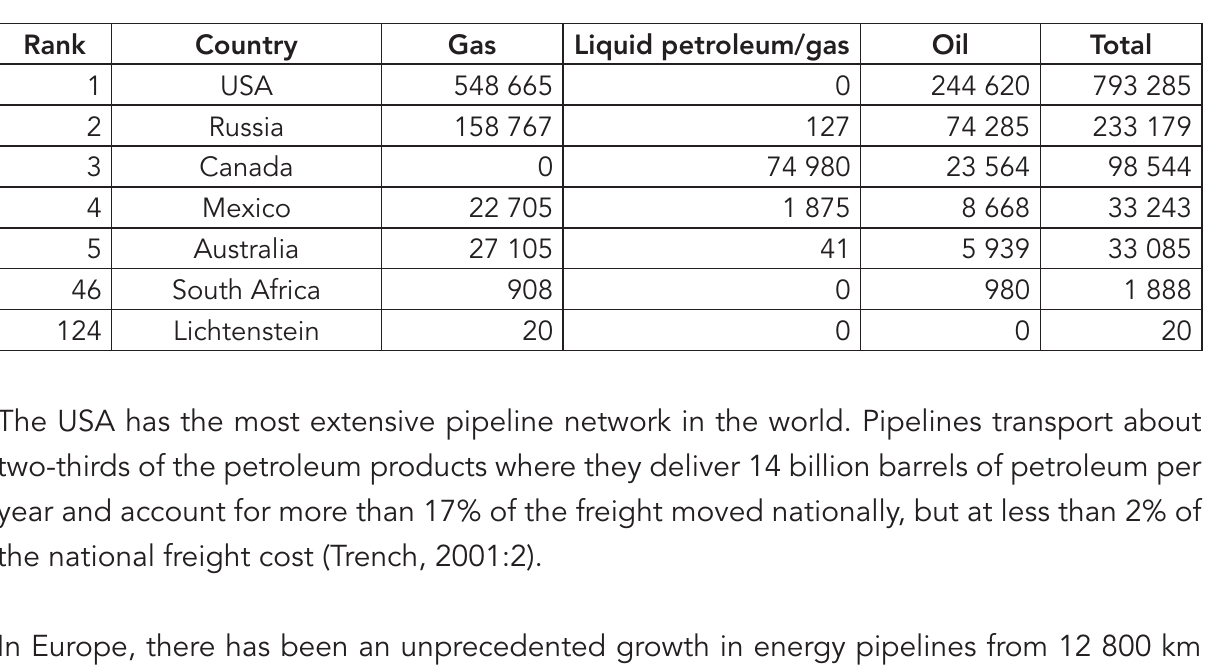
Table 1: Pipelines lengths (km) of selected